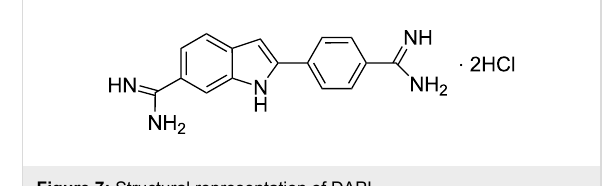
Figure 7: Structural representation of DAPI.